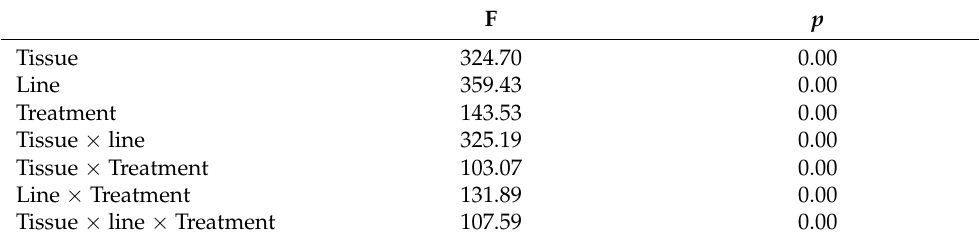
Table 6. Effects of line, tissue, treatment, the interaction of line x tissue, the interaction line x treat- ment (treat), the interaction of tissue x treatment, and the interaction of line x tissue x treatment on the expression of the DREB1B gene for the studied lines of M. truncatula under control treatment, 30% FC, and 100 mM NaCl.